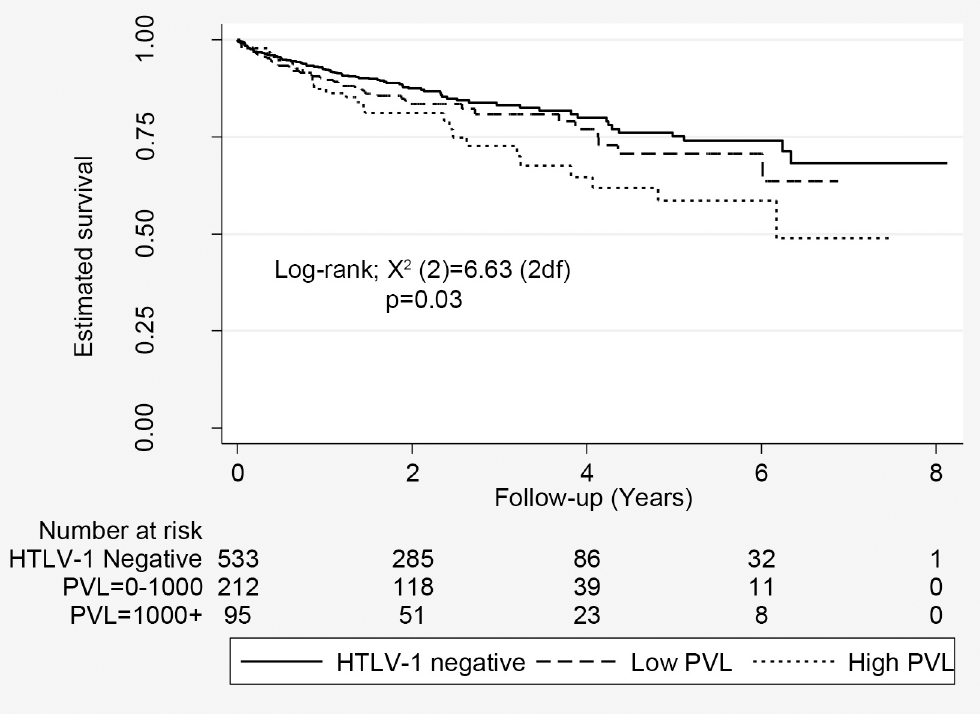
Fig 3. Estimated survival according to HTLV-1 proviral load. Includes 533 HTLV-1 uninfected subjects, 212 subjects with low HTLV-1c proviral load ( < 1000 copies per 10 5 peripheral blood leukocytes) and 95 subjects with high HTLV-1c proviral load ( (cid:21) 1000 copies per 10 5 peripheral blood